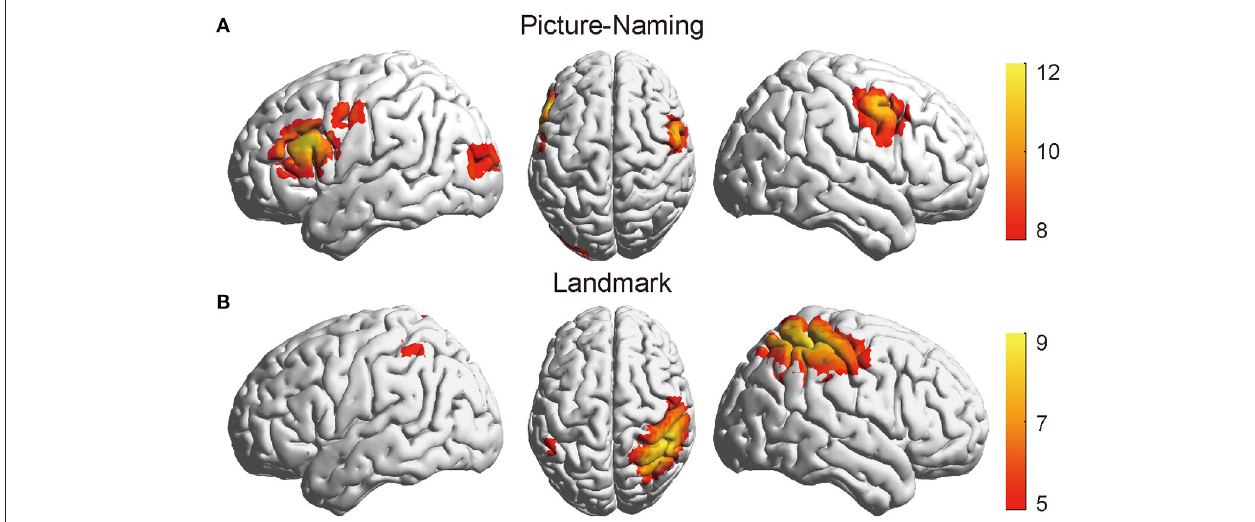
FIGURE 3 | The thresholded activation t-maps of the picture-naming and landmark tasks. (A) The brain showed strong activation in the IFG area of the left hemisphere in the picture-naming task (FDRBH corrected, q < 0.05). (B) The brain showed increased activation in the IPS/SPL of the right hemisphere in the landmark task (FDRBH corrected, q < 0.05). IFG, left inferior frontal gyrus; IPS/SPL, inferior parietal sulcus, and the superior parietal lobule areas.